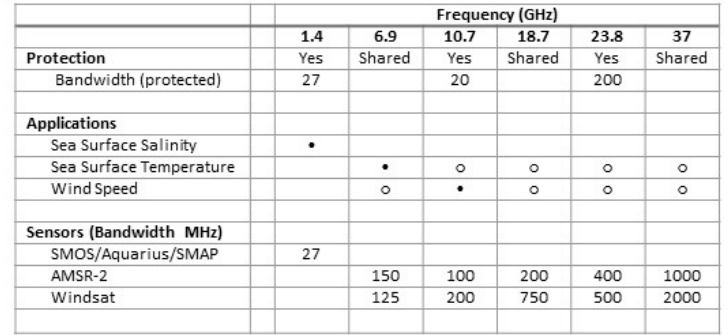
Figure 1. Frequency and bandwidth used by passive microwave sensors in space. The solid circles indicate the primary frequency (best sensitivity to the identified parameter desired) and the open circles indicate other frequencies employed in the retrieval algorithms to help correct for competing effects on observed emissivity.